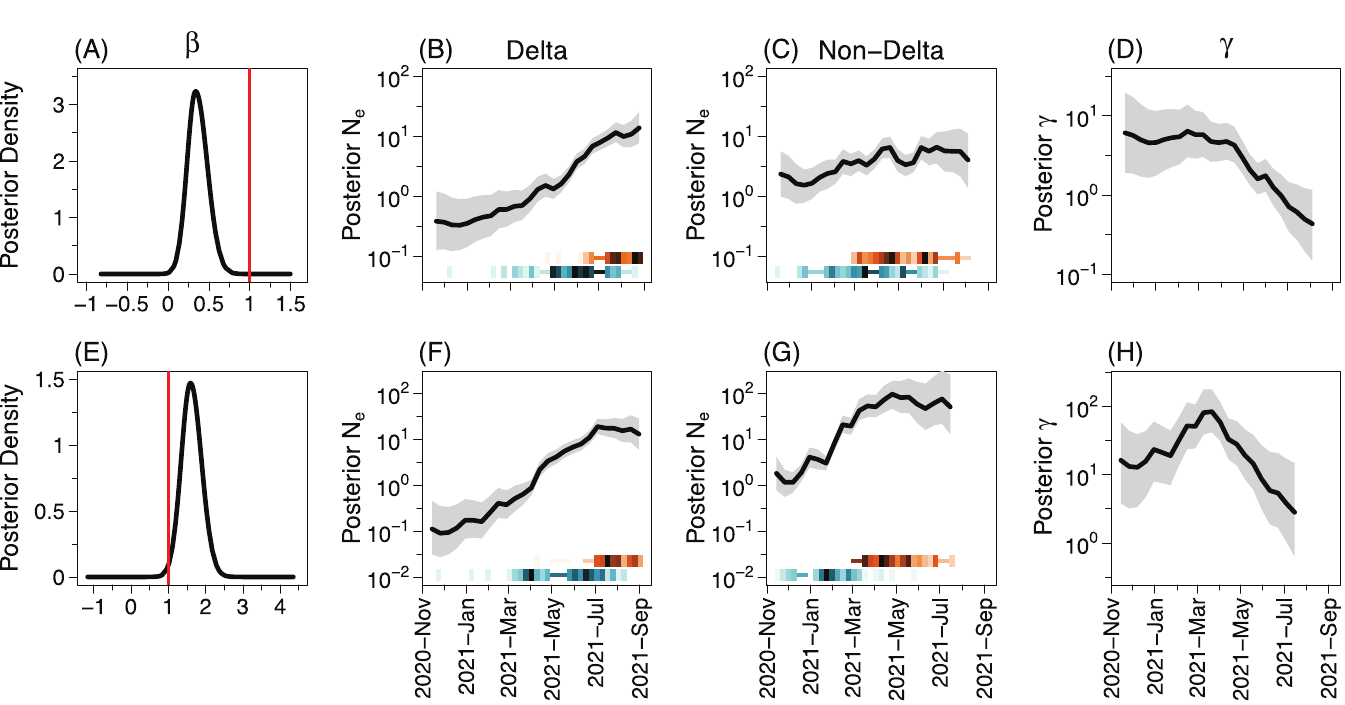
Fig 4. Posterior inference of SARS-CoV-2 population dynamics in South Korea and Italy. Panels A–D contain results of South Korea, and the panels E–H show results of Italy with g A =delta and g B =non-delta. The first column shows the β parameter posterior density from the parPop method. The red line indicates the value of β under the hypothesis that both variants share the same EPS trajectory in the parPop model. The other columns present the results with adaPop+Pref: the second and the third columns display posterior estimates of EPS of the delta and non-delta variant, respectively, and the last column shows posterior estimates of γ . The solid line indicates the posterior medians with its surrounding shaded areas representing 95% BCIs. The orange and blue heatmaps describe the sampling and coalescent event intensity, respectively: the darker the color, the more number of events occurs in a time interval. The y -axis of plots in the columns 2–4 is plotted on a log scale. The results using other methods can be found in the Figs D–F in S1